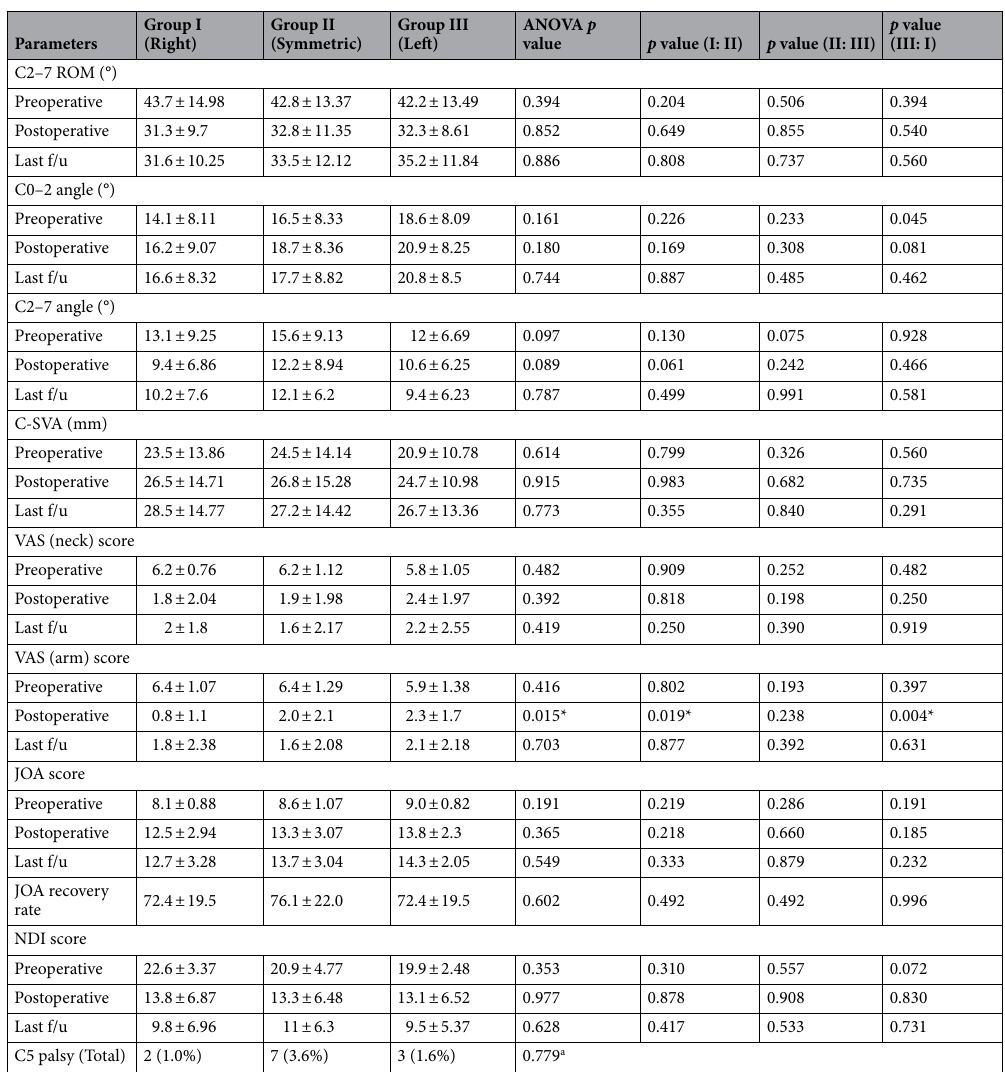
Table 4. Comparison of outcomes according to dominant myelopathy symptom side. Significant are in value [bold]. C-SVA indicated cervical sagittal vertical axis; VAS visual analog scale; JOA Japanese orthopaedic association; NDI neck disability index. a Chi-square test. *Statistically significant ( p value <